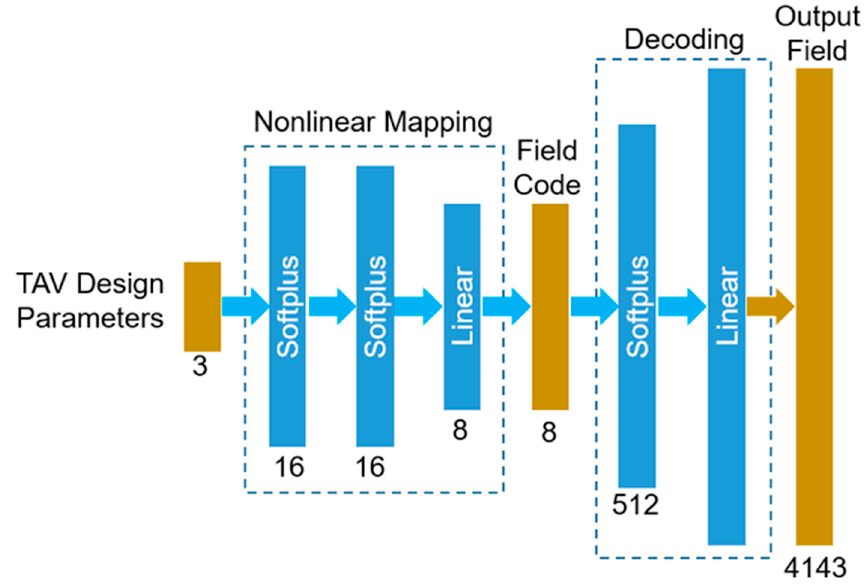
Figure 4. The structure and data flow of the autoencoder-based ML-models.